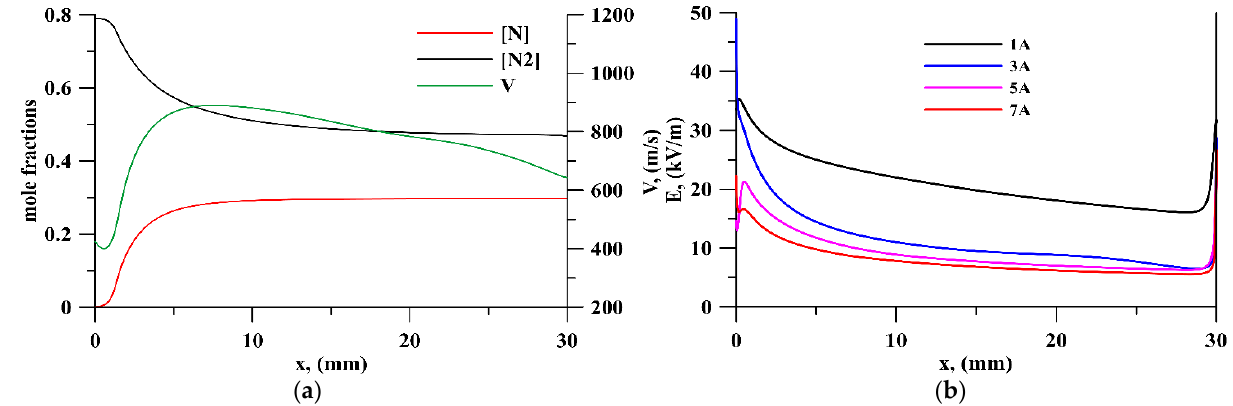
Figure 11. Longitudinal distributions of N 2 and N mole fractions supplemented with a velocity profile for r = 0.7 mm and a discharge current of 5 A ( a ); longitudinal distribution of the electric field at r = 0 mm ( b ).